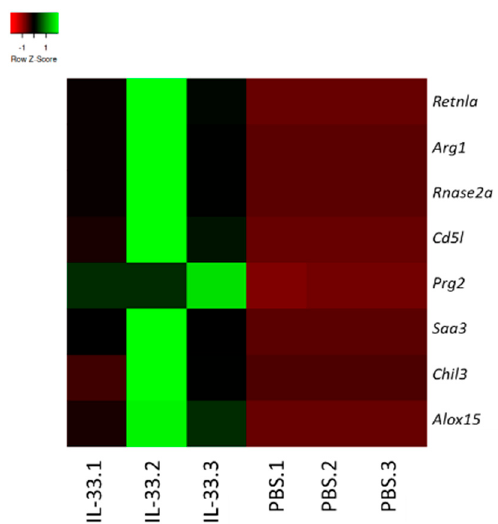
Figure 5. IL-33 treatments upregulated M2-related immunosuppressive genes. Total RNA was extracted from peripheral blood of NZB / W F1 mice at week 2 of IL-33 / PBS treatments. Heatmap of genes showing di ff erential expression in the IL-33 and PBS group. Genes were filtered for moderate to high expression and fold change > 2. Green is high expression, red is low expression, and black is intermediate. n = 3. Retnla , resistin-like molecule alpha / FIZZ1; ARG1 , arginase 1; Rnase2a , ribonuclease A family member 2; CD5L , CD5-molecule-like; Prg2 , proteoglycan 2; Saa3 , serum amyloid A3; Chil3 , chitinase-like 3; Alox15 , arachidonate 15 lipoxygenase.